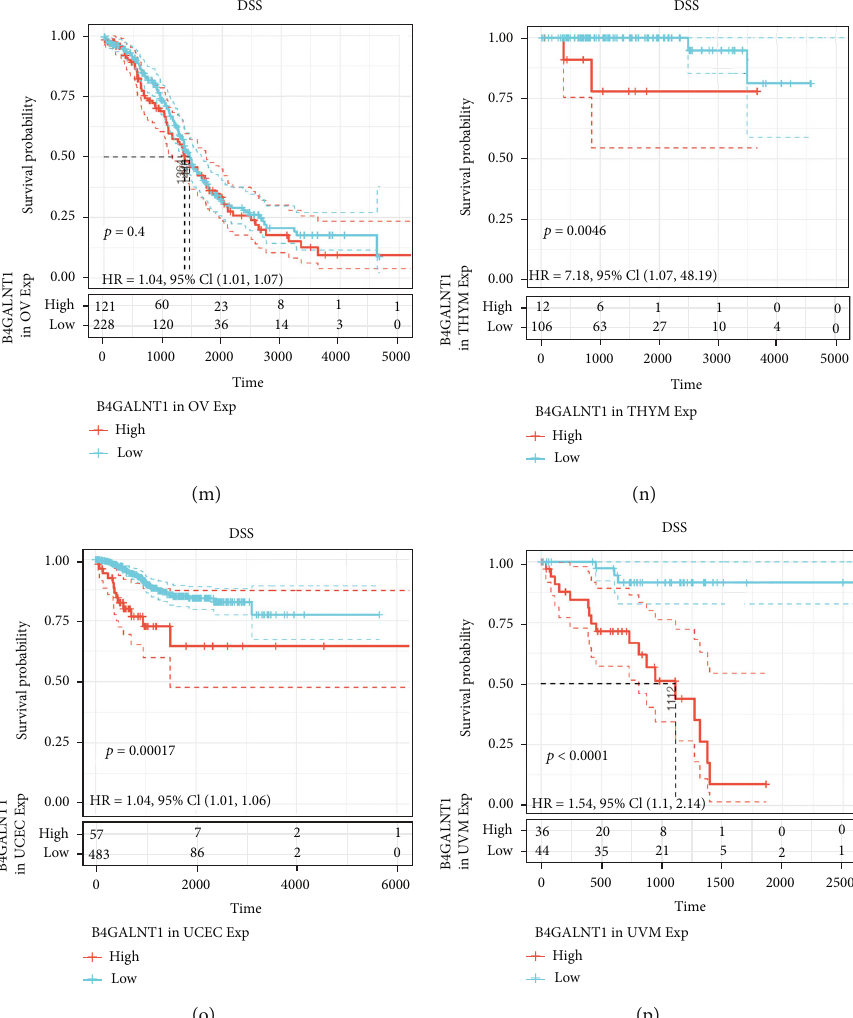
Figure 3: (a, b) Survival analysis of B4GALNT1 expression using Kaplan-Meier DFI curves in CHOL and THCA. (c – p)Survival analysis of B4GALNT1 expression using Kaplan-Meier DSS curves in ACC, BLCA, CHOL, COAD, HNSC, KICH, KIRP, LGG, LUAD, MESO, OV, THYM, UCEC, and